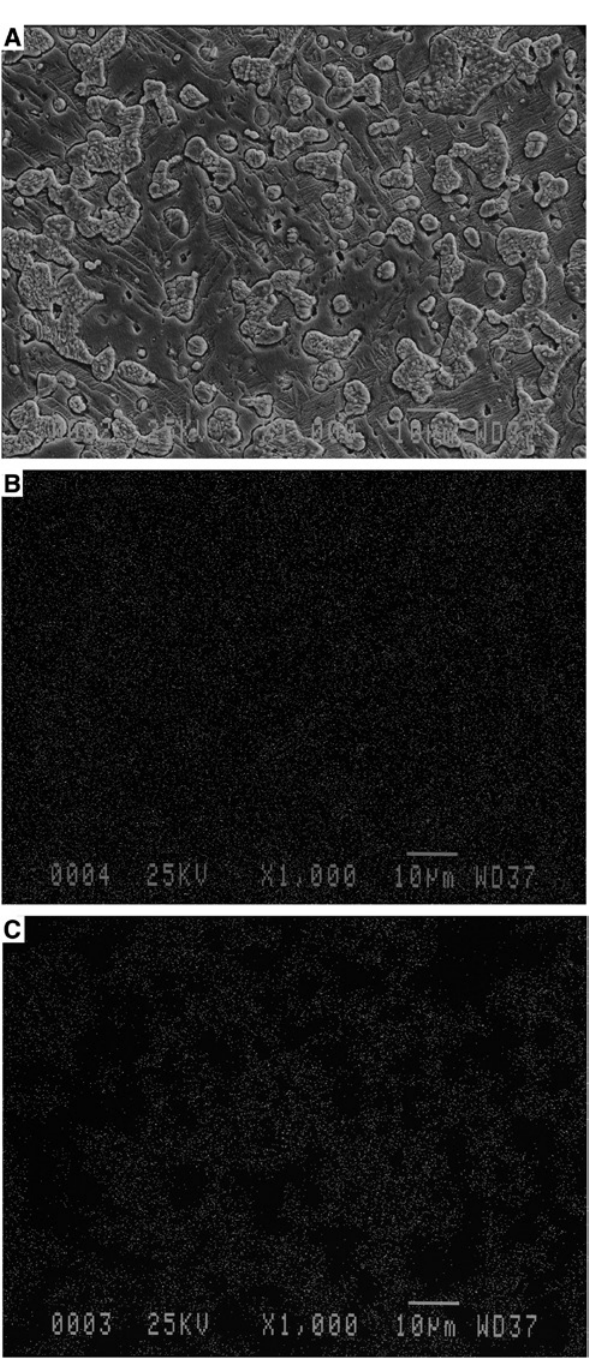
Figure 6: Microstructure of the sintered samples: (A) SEM image of densified samples. (B) Corresponding elemental map analysis of silver. (C) Corresponding elemental map analysis of chromium.